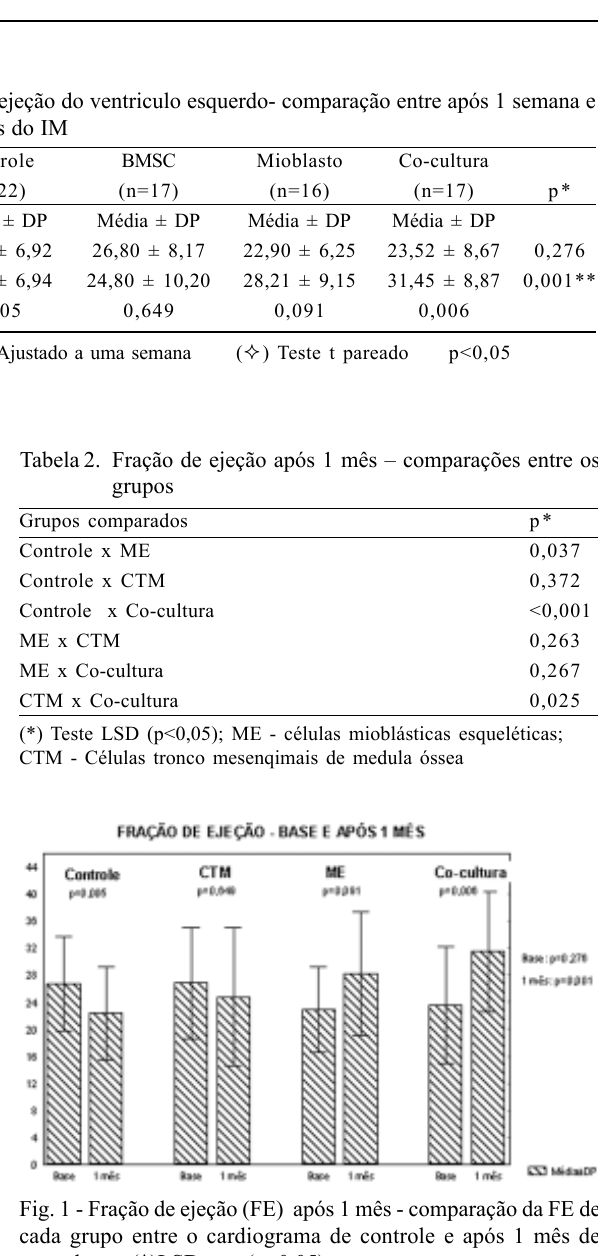
cada grupo entre o cardiograma de controle e após 1 mês de transplante. (*)LSD test